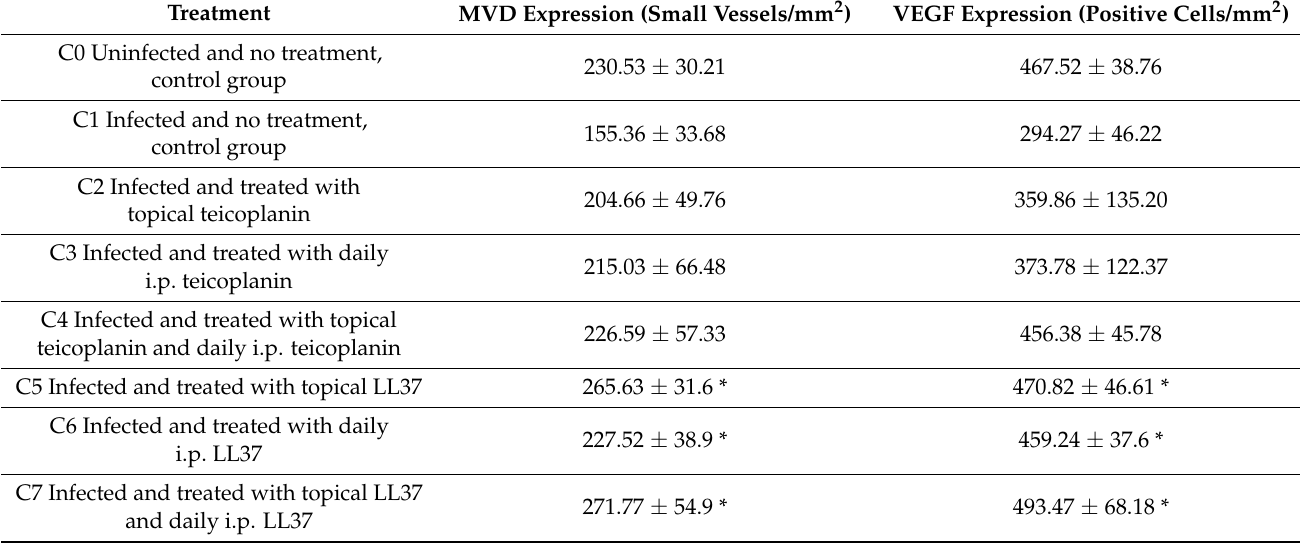
Table 2. Micro-vessels density (MVD) and number of VEGF positive cells at day 7 post-wounding. Data are expressed as the mean score ±